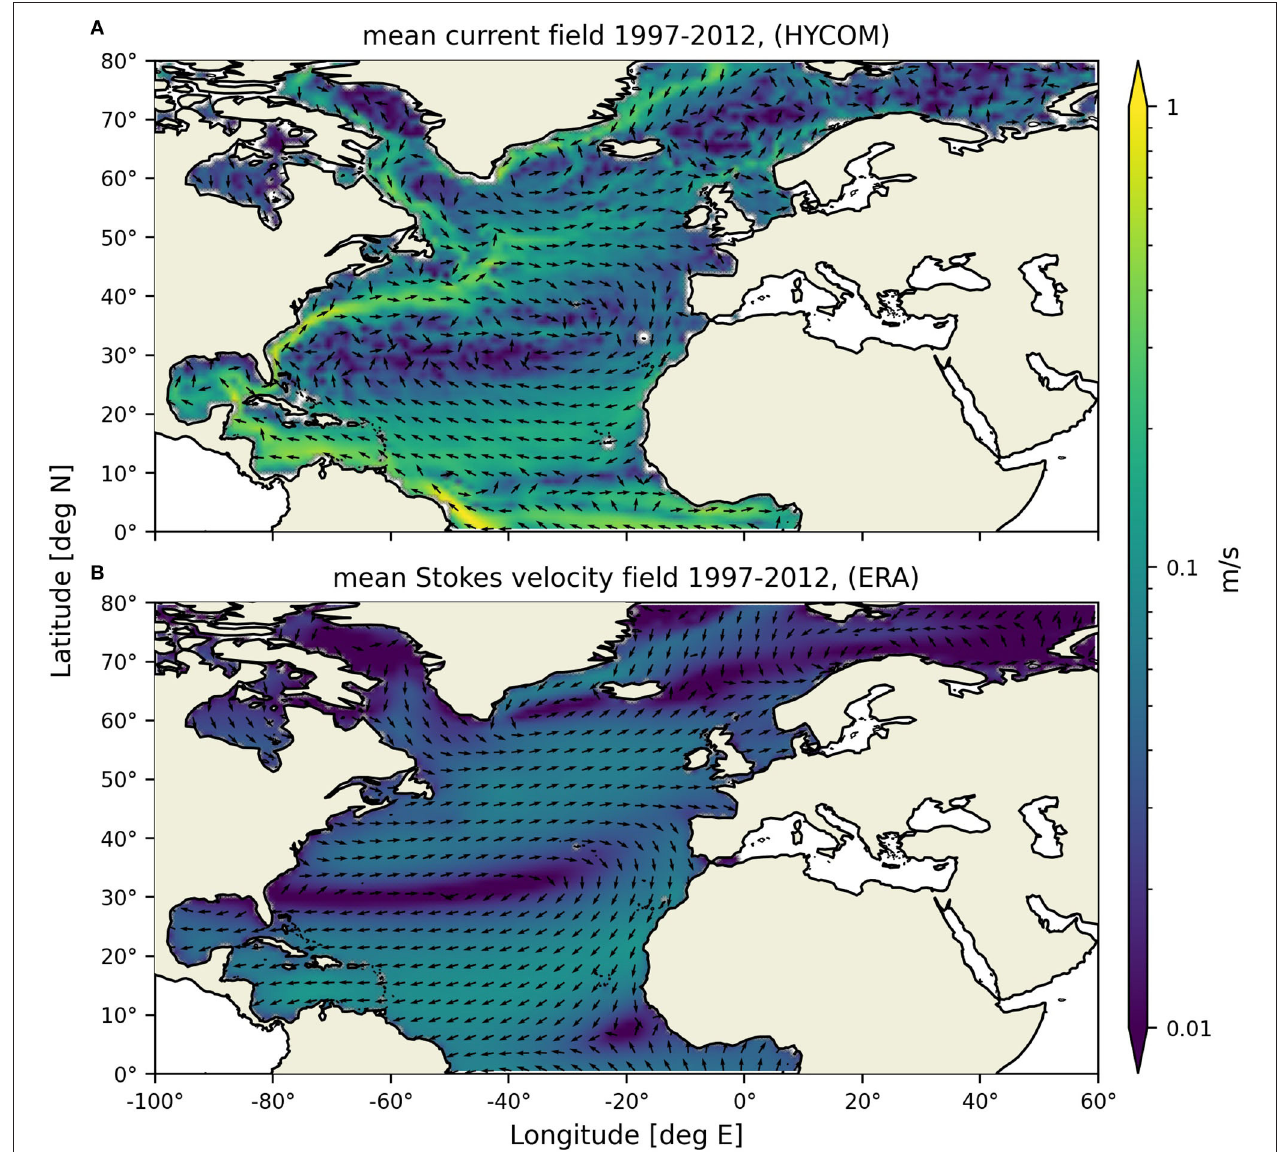
FIGURE 1 | Current and Stokes drift velocities in the North Atlantic from global reanalysis ocean and wave models, HYCOM (A) and ERA-Interim (B) , averaged over years 1997–2012. Note the logarithmic colour-scale.